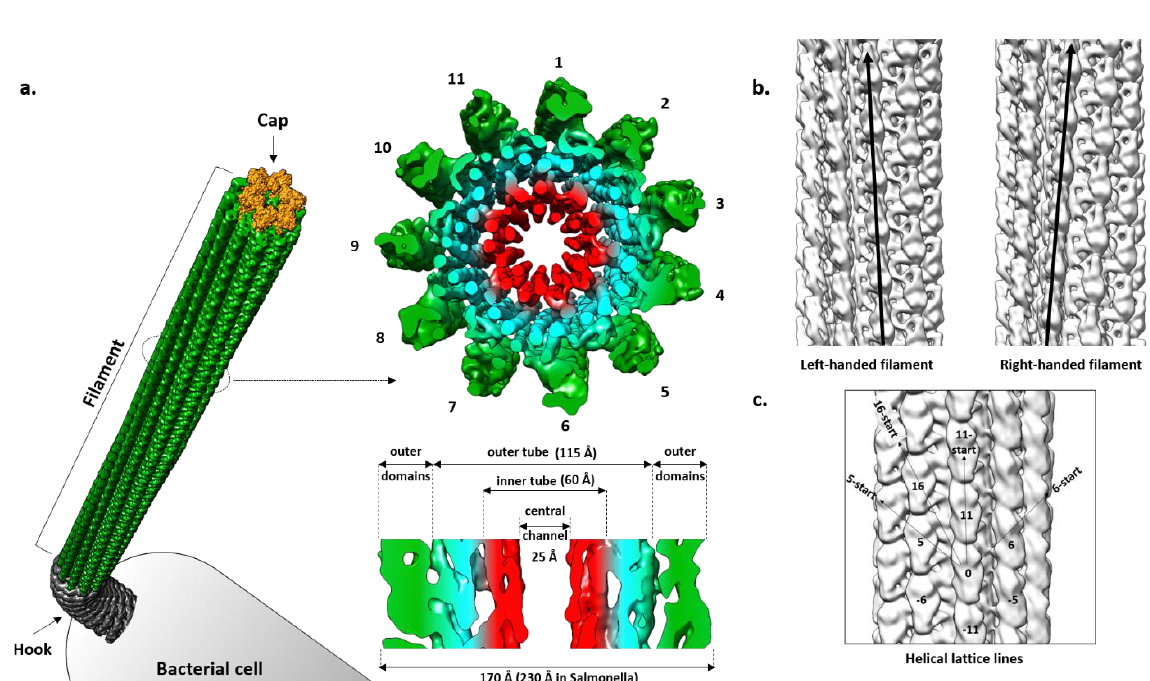
Figure 2. Cryo-EM structure of the flagellar filament from P. aeruginosa PAO1. ( a ) Cross-section of the left-handed filament consisting of 11 protofilaments. The inner tube (red) made of D0 domains and outer tube (cyan) together form the densely packed inner core of the filament. Outer domains are shown in green; ( b ) Left- and righ-handed filaments with all protofilaments tilted to the left and right from the central axis; ( c ) Helical symmetry lines in the filament. EMD: 8855, 8856.